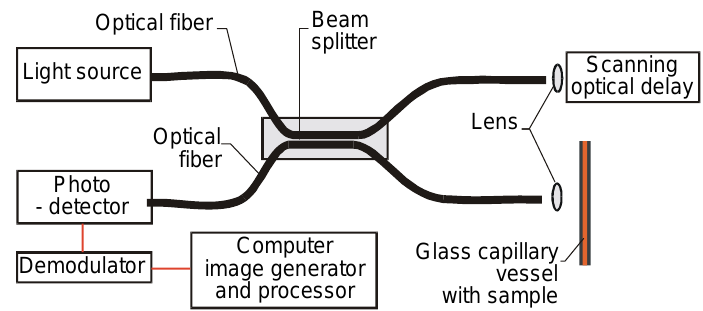
Figure 5. OCT system using optical capillary as a